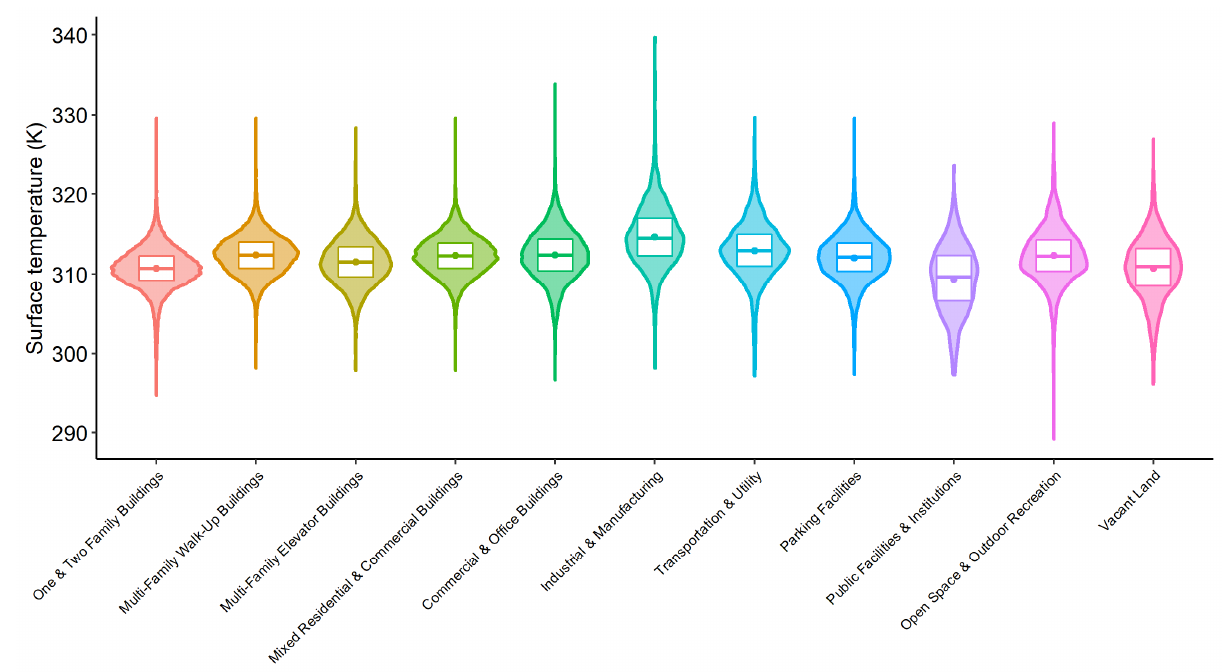
Figure 6. The violin chart with boxes represents the interquartile range (IQR) of surface temperature in individual building’s land use category in New York City. Mean (filled circle) and median (full line inside the box) is also shown.